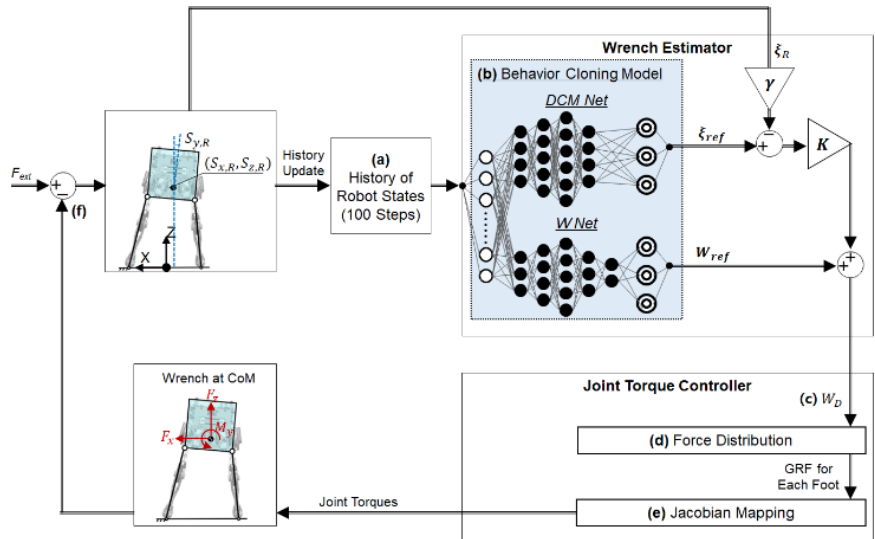
Figure 6. Schematic diagram for the control process of the robot balancing: ( a ) At each control loop, the oldest robot state is removed, and the current robot state is inserted to update the data to be provided to the wrench estimator. ( b ) The behavior cloning model with two separate networks: DCM Net and W Net . The two networks use the same input data of robot states but yield different outputs: ξ ref and W ref , respectively. ( c ) The desired wrench at the CoM ( W D ) is computed from the outputs of the behavior cloning model. ( d ) GRF of each foot is computed from desired wrench at CoM. ( e ) Joint torques are computed from the GRF using the Jacobian matrix of each leg. ( f ) GRFs from both feet generate the net wrench at the CoM to maintain balance.